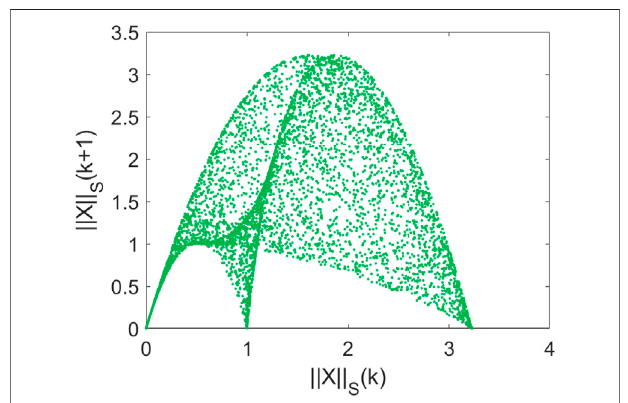
FIGURE 14 | Return (cid:3) X( k ) (cid:3) S − (cid:3) X( k + 1) (cid:3) S map for the multidimensional logistic map with N = 2 for a =